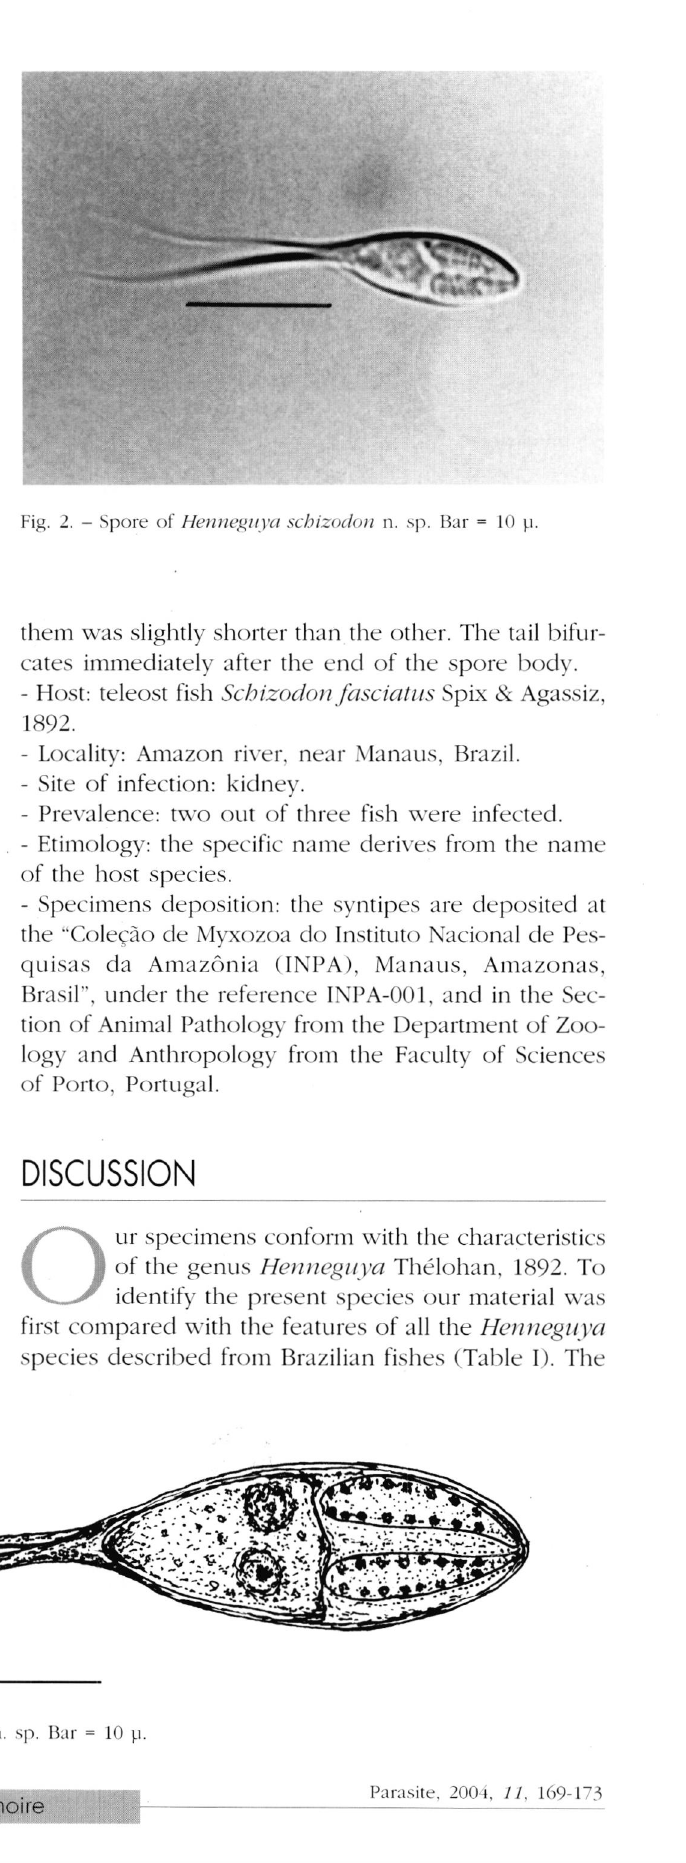
Fig. 1. - Schematic drawing of the spore of Henneguya schizodon n. sp. bar = 10